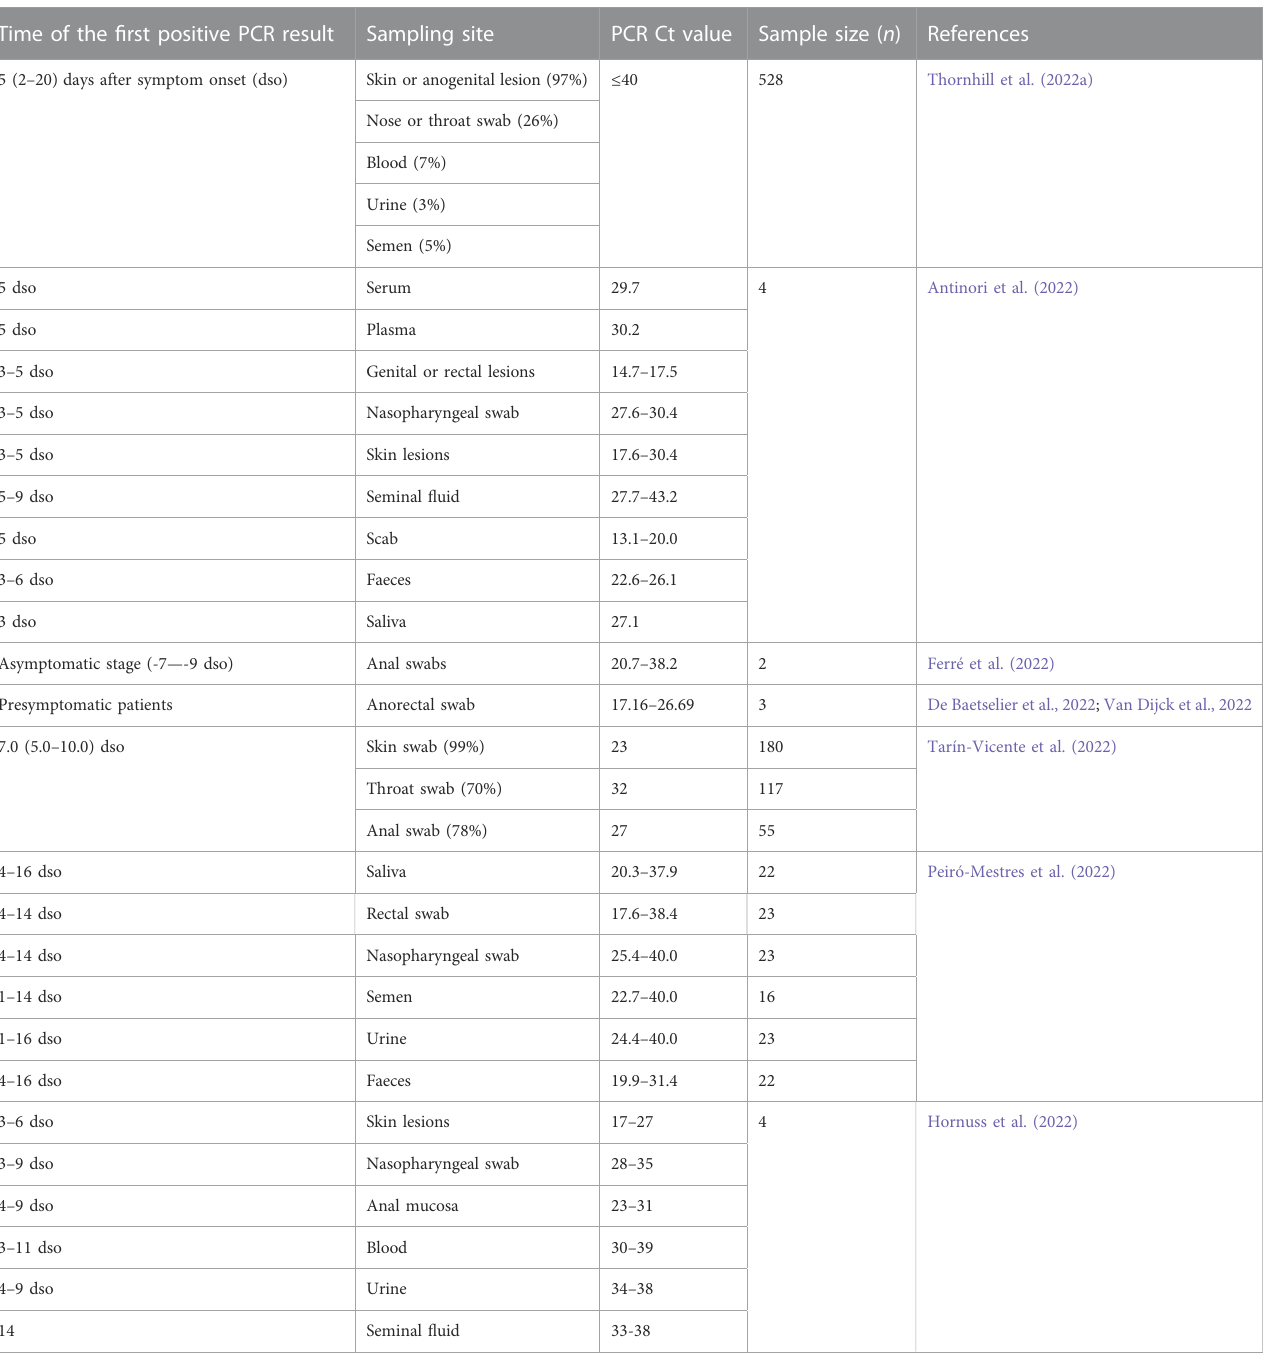
TABLE 1 Timeline of PCR results from mpox cases in